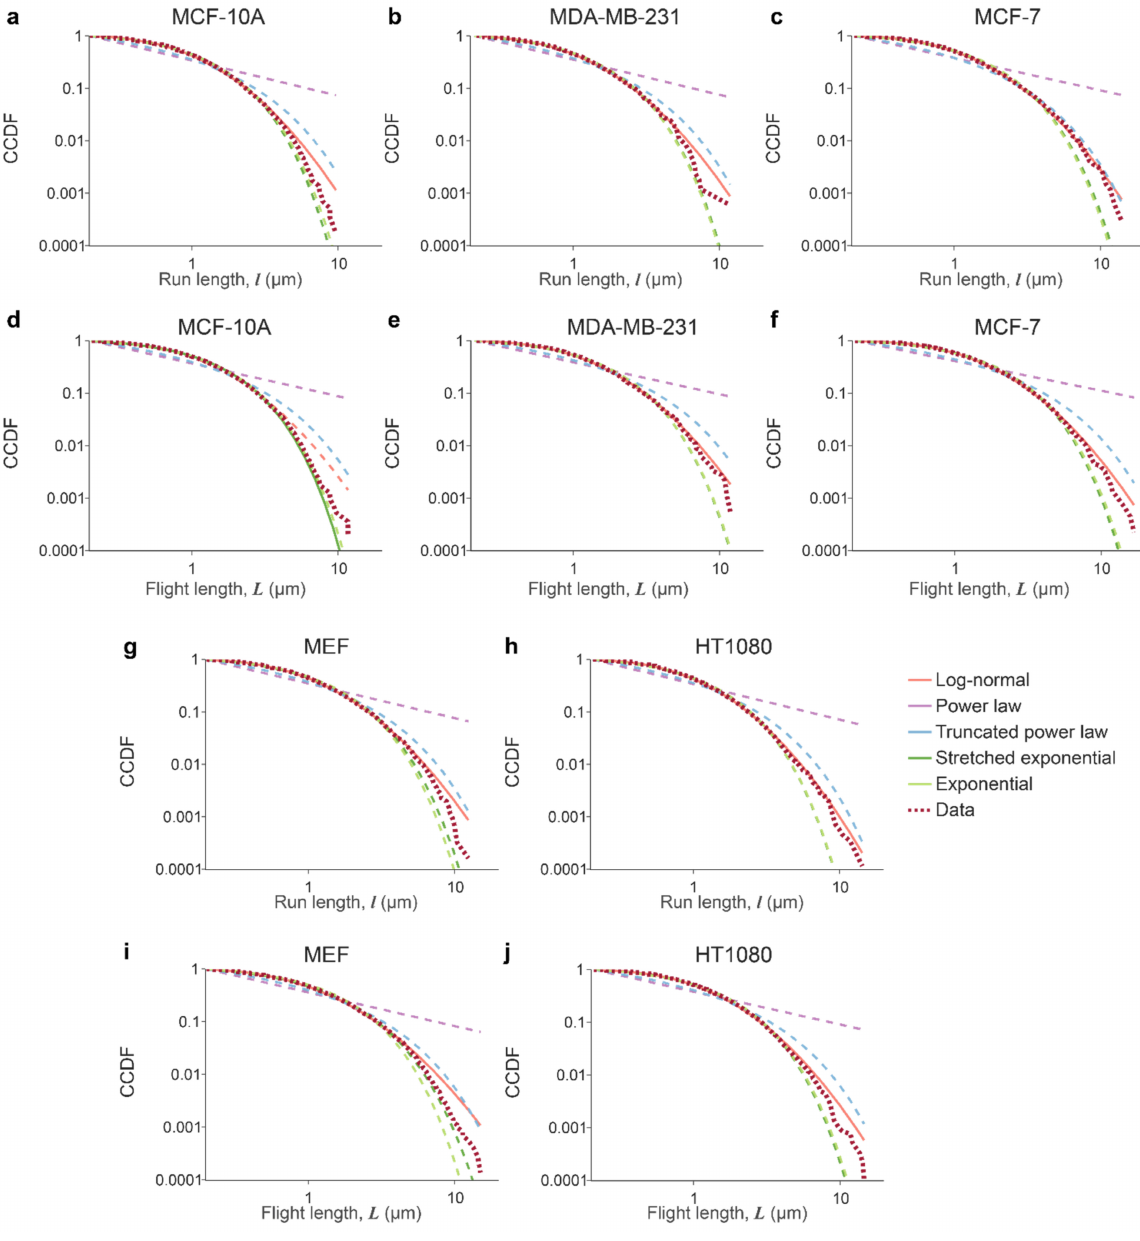
Figure A1. CCDFs of datasets with corresponding distribution fits. Subpanels show curves for run ( a – c , g , h ) and flight ( d – f , i , j ) lengths for MCF-10A ( a , d ), MDA-MB-231( b , e ), MCF-7 ( c , f ), MEF ( g , i ), and HT1080 ( h , j ) cells. Data CCDF curves are in burgundy dotted lines; best-fit distributions are plotted in solid lines, while competing distributions are in dashed